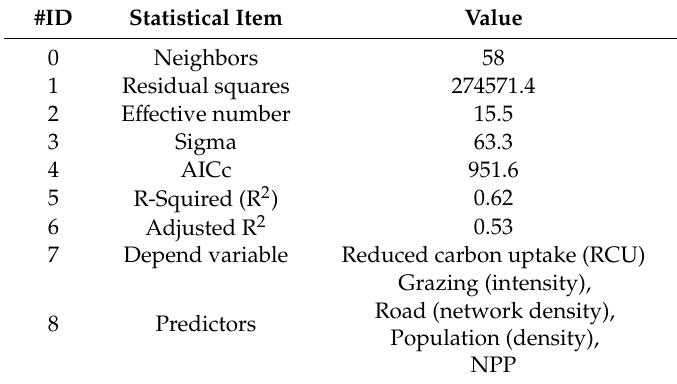
Table 4. Statistics from a geographically weighted model (GWR) for the carbon gap using the explanatory variables. #ID Statistical Item